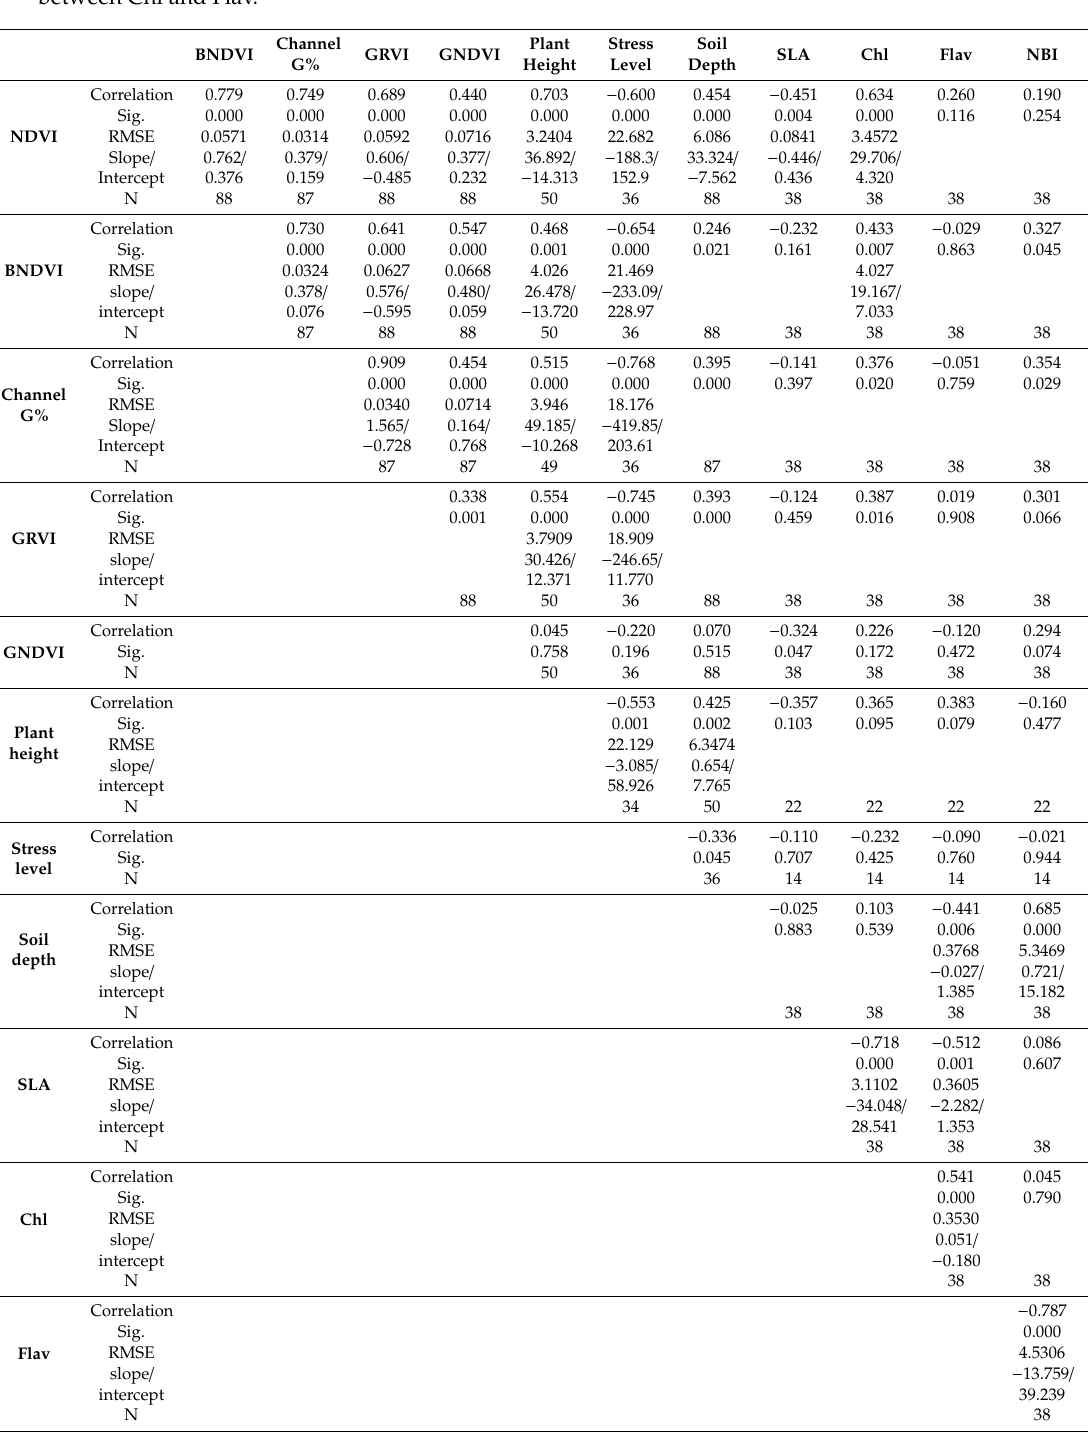
Table 4. Correlations between greenness indices and plant traits at plot level. Root Mean Squared Error (RMSE) of the linear regressions (slope, intercept) is computed for significant correlations with r > 0.4. Chl = chlorophyll content, Flav = flavonol absorbance, and NBI = nitrogen balance index, i.e. the ratio between Chl and